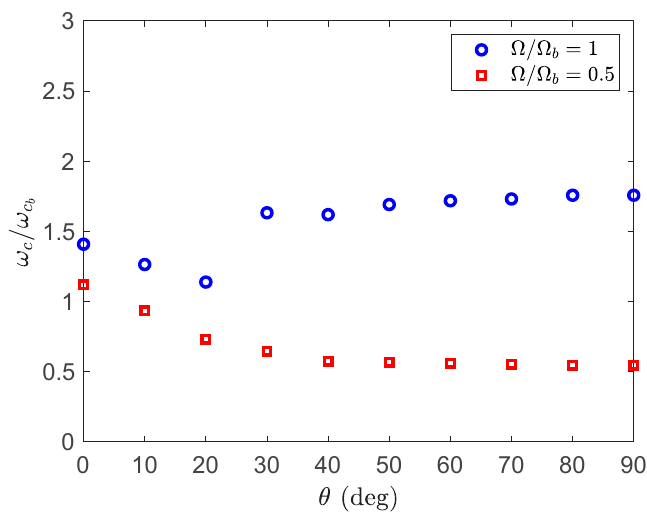
Figure 11. The effect ply angle on the critical instability frequency.